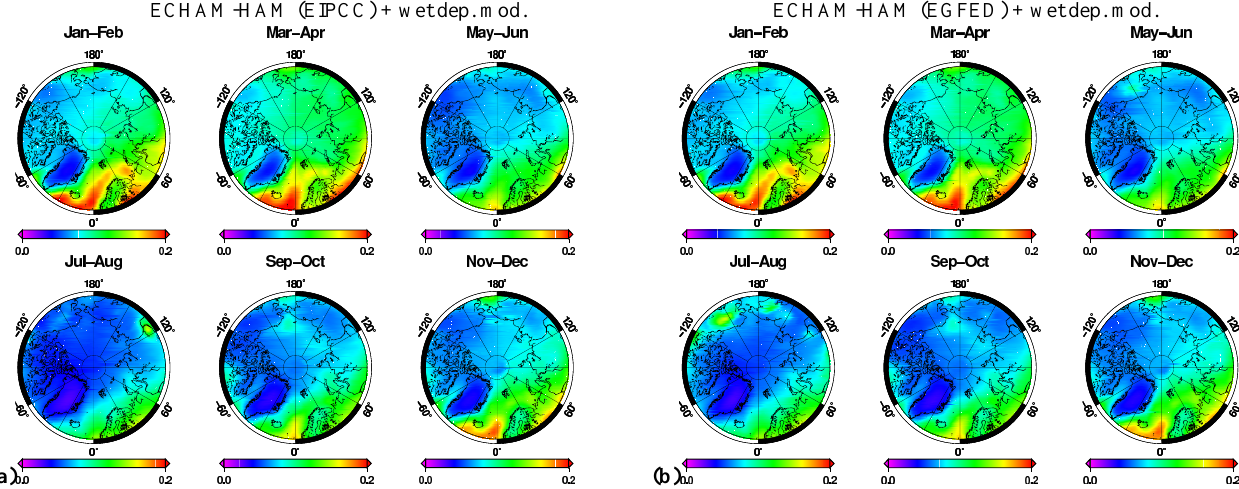
Fig. 7. Maps of average AOD in different periods of the year. Monthly means are calculated in the period 2003 to 2006, common to all datasets. Panels: (a) ECHAM-HAM (EIPCC) with the Bourgeois and Bey (2011) modification. (b) ECHAM-HAM (EGFED) with the Bourgeois and Bey (2011)